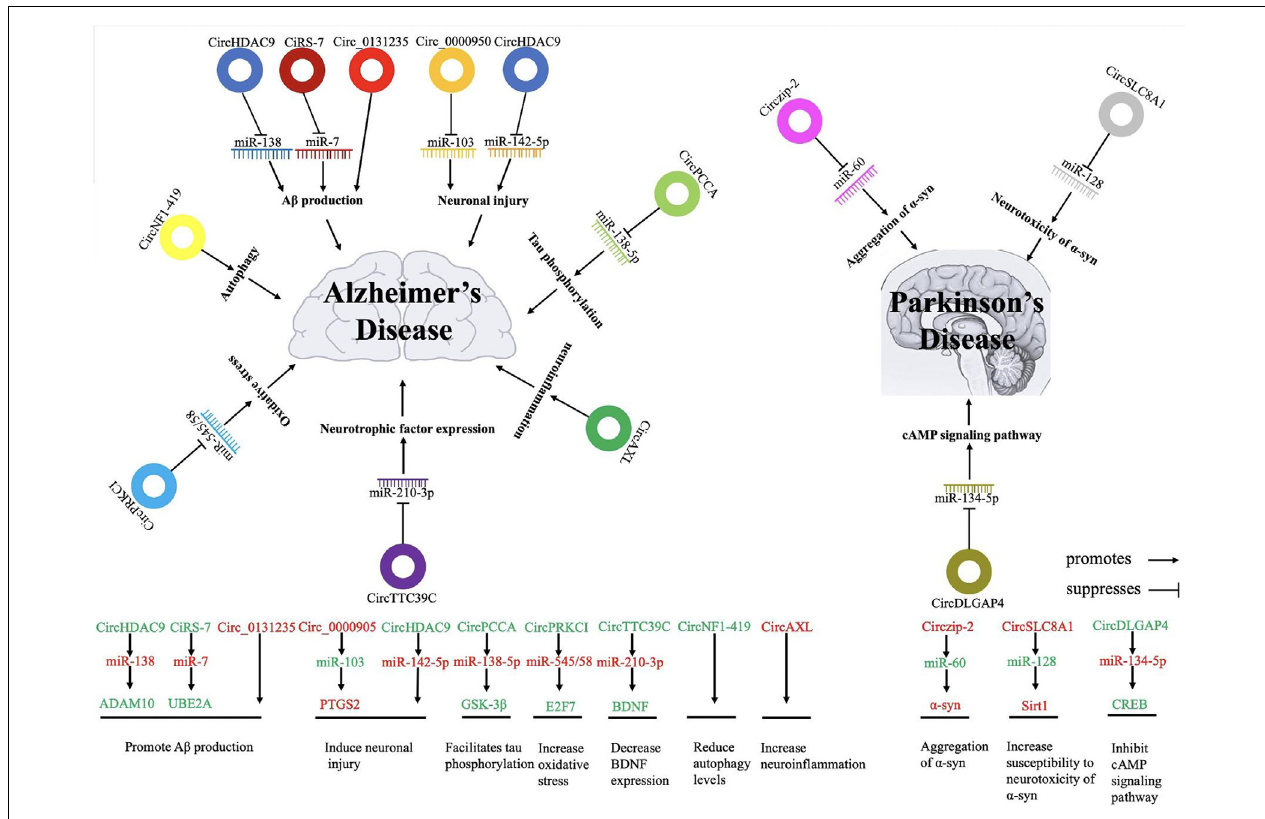
FIGURE 1 | The possible roles and regulatory mechanisms and targets of circular RNAs and their impacts on the development of Alzheimer’s and Parkinson’s disease (PD). Red words indicate the upregulated non-coding RNAs and green words indicate the downregulated non-coding RNAs. circRNA, circular RNA; miR,